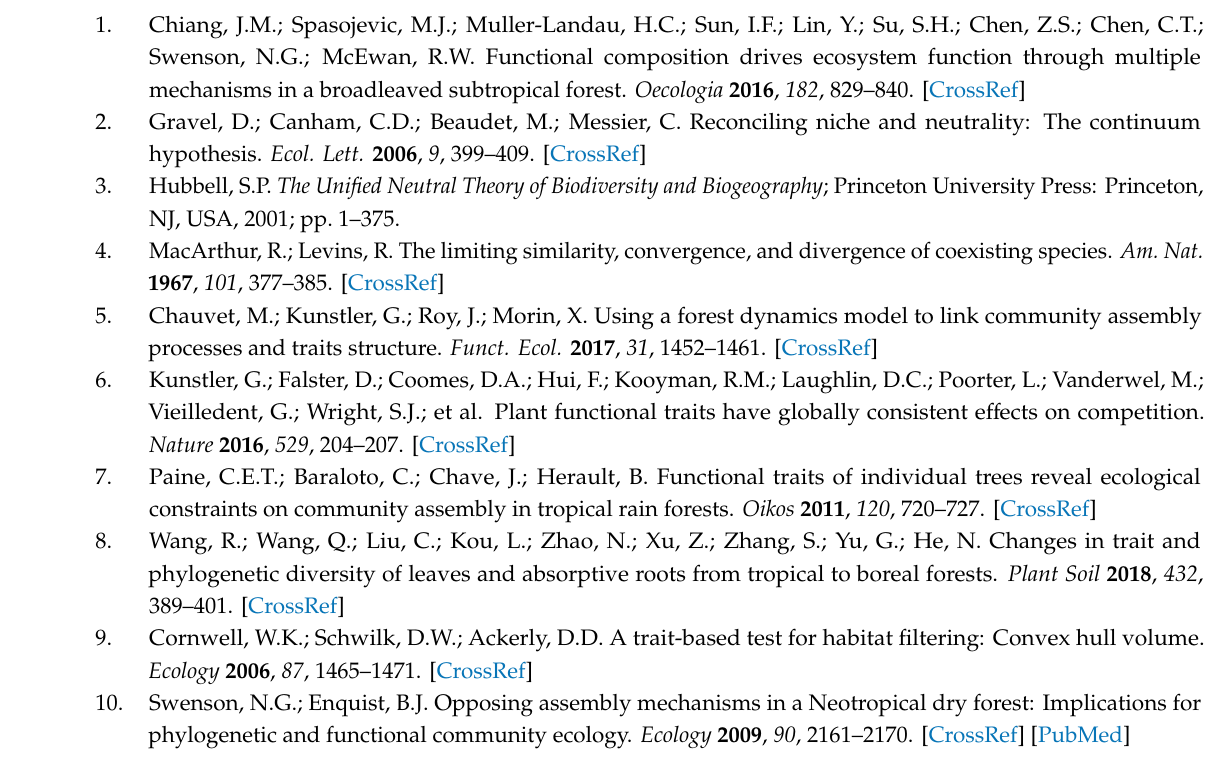
Table S1: The mean functional trait values of 134 species in Dinghushan Forest Dynamics Plot, China, Table S2: The mean species abundance and richness across three ontogenetic stages and five habitat types, Table S3: Testing spatial autocorrelation by Moran’s I for standardized e ff ect size of functional dispersion (ZFDis) of six functional traits across three ontogenetic stages, Table S4: Testing spatial autocorrelation by Moran’s I for standardized e ff ect size of functional dispersion (ZFDis) of a multivariate trait (AT) that considered all trees across four spatial